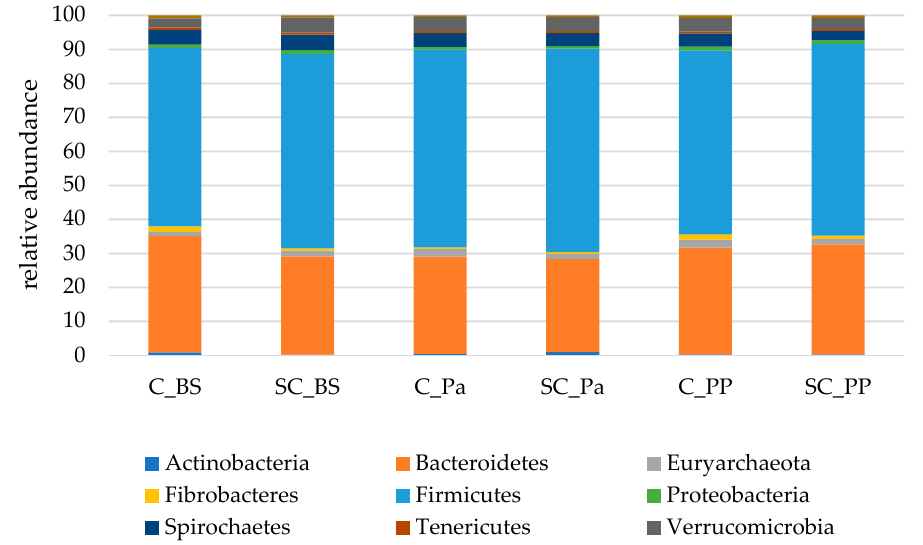
Figure 4. The relative abundances of the main bacterial and archaeal phyla in the fecal samples of both the experimental groups (Control C and Supplemented SC, n = 6 per group) BS (before supplementation), Pa (close to parturition) and PP (2 weeks postpartum).